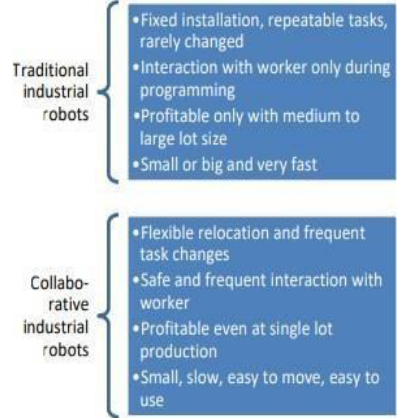
Fig 1: Comparison of collaborative robots and traditional industrial robots El Zataari et al.